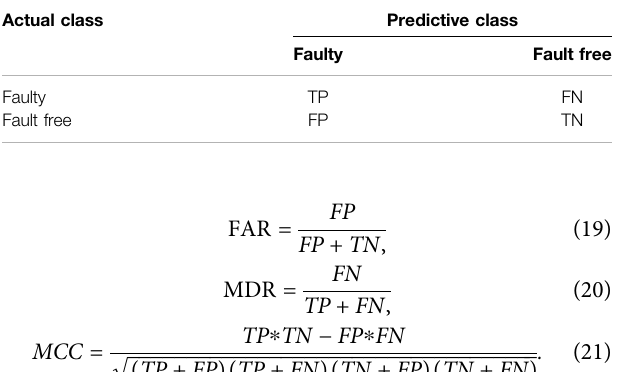
TABLE 6 | Confusion